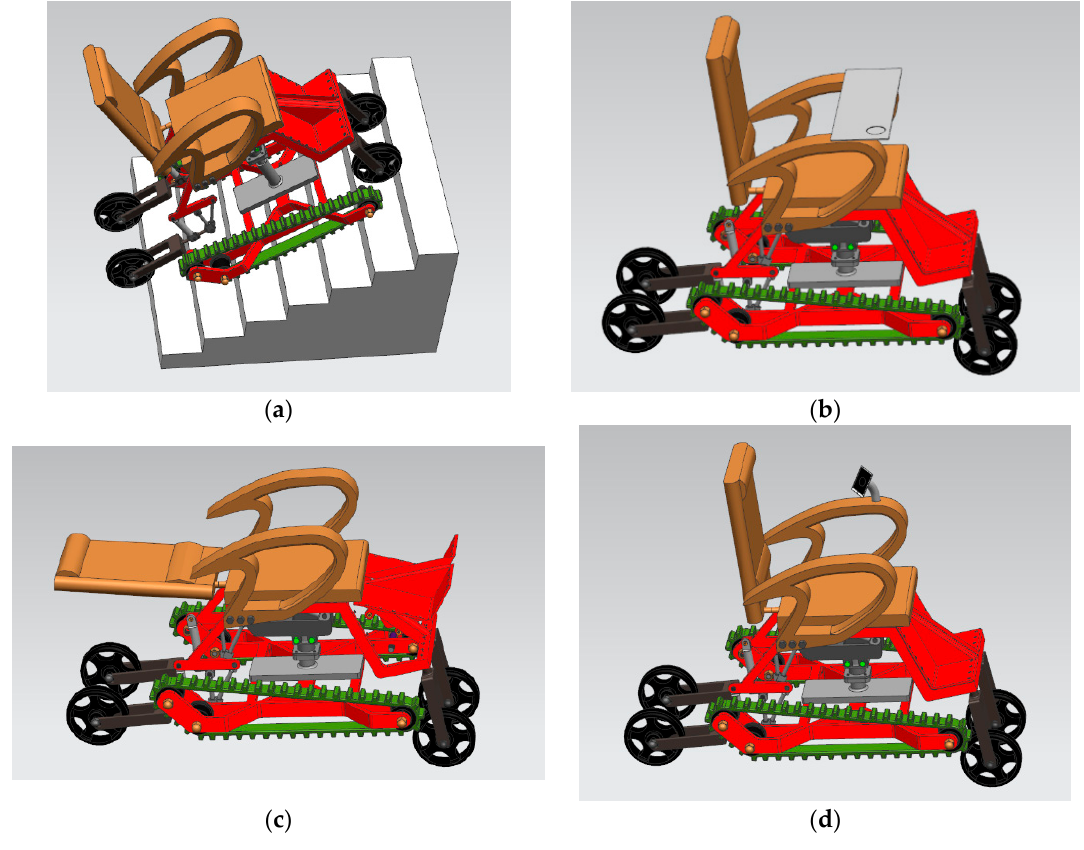
Figure 13. The first conceptual design of the wheelchair. ( a ) in climbing state, ( b ) in working state, ( c ) in sleeping state, ( d ) in navigation state.